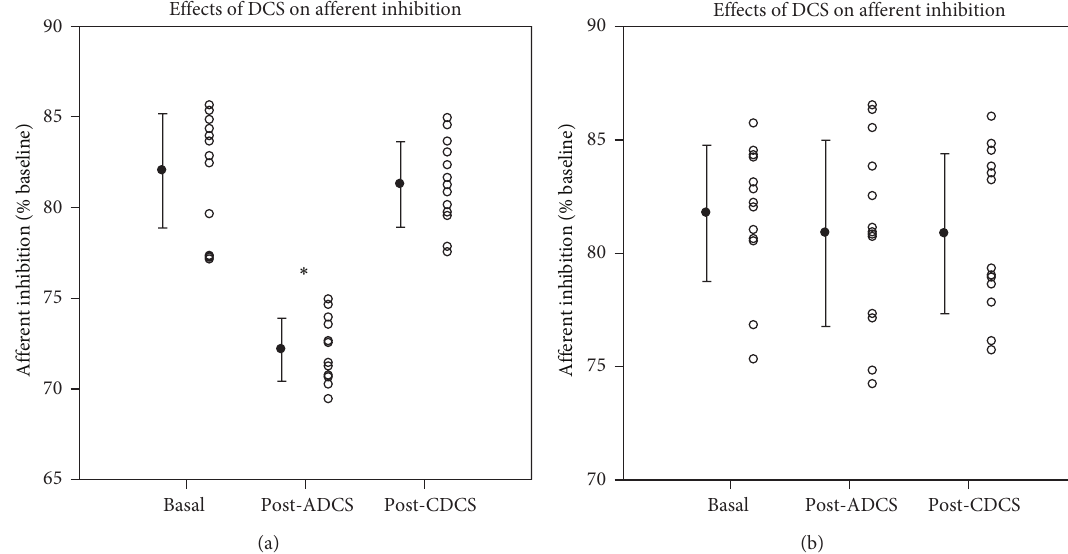
Figure 5: Effects of direct current stimulation (DCS) on afferent inhibition in left gastrocnemius muscle (a) and right gastrocnemius muscle (b) at baseline, after application of anodal DCS (ADCS) and cathodal DCS (CDCS) over left cerebellar hemisphere. A conditioning stimulus is applied on the sciatic nerve contralaterally to the stimulated motor cortex (right motor cortex and left motor cortex for (a) and (b), resp.) with an interstimulus interval of 45 msec. The afferent inhibition is expressed in % of baseline motor responses (obtained without conditioning stimulus). Mean values of motor evoked responses obtained in the baseline condition are set at 100% for each motor cortex. Mean values (filled circles; ± SD) as well as individual values (open circles) are shown. Cerebellar ADCS enhances the afferent inhibition for the ipsilateral muscle. ∗ 𝑃 < 0.05 ( 𝑛 = 13